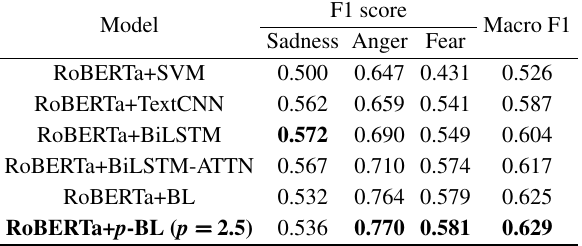
Table 6 Performance of different methods on Virus dataset.